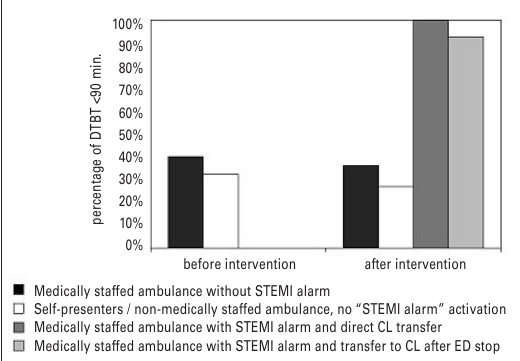
Figure 2 Proportion of STEMI patients with DTBT <90 minutes before and after interven- tion, depending on admission mode and activation of prehospital “STEMI